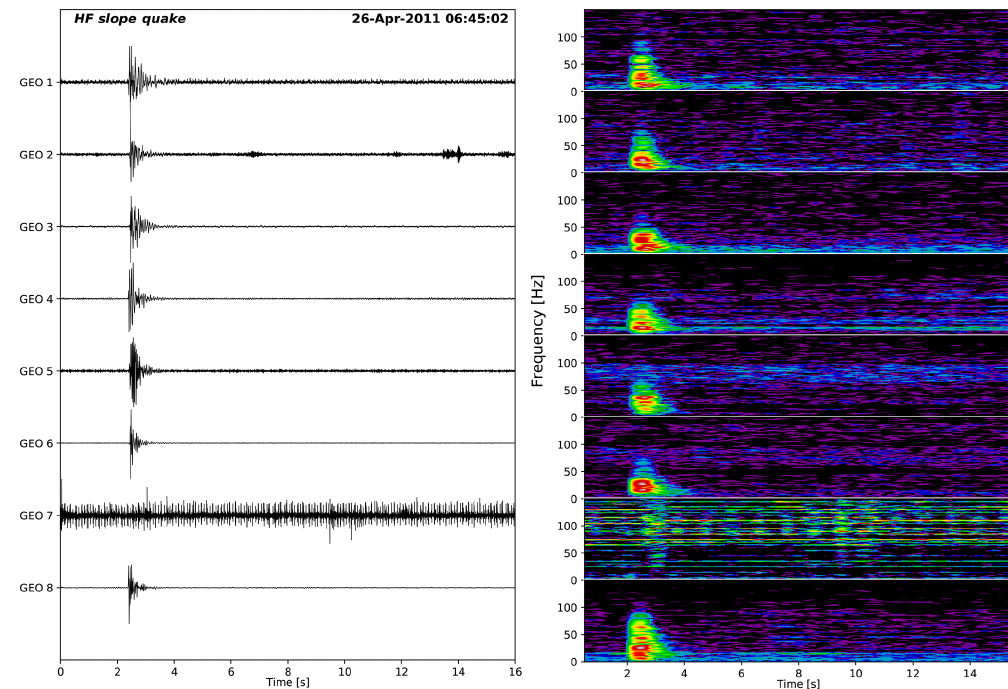
Figure B1. Example of a high-frequency (HF) slope quake. Geophone 7 was not functional.